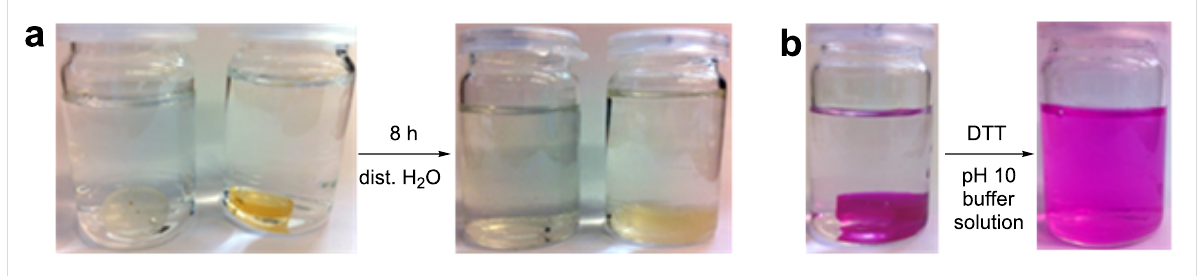
Figure 2: (a) Behavior of poly(DEAAm- co -DMAEMA) (left) and cross-linked poly(DEAAm- co -DMAEMA) (right) in distilled water. (b) Reductive cleavage of cross-linked poly(DEAAm- co -DMAEMA) networks containing phenolphthalein in pH 10 buffer solution.